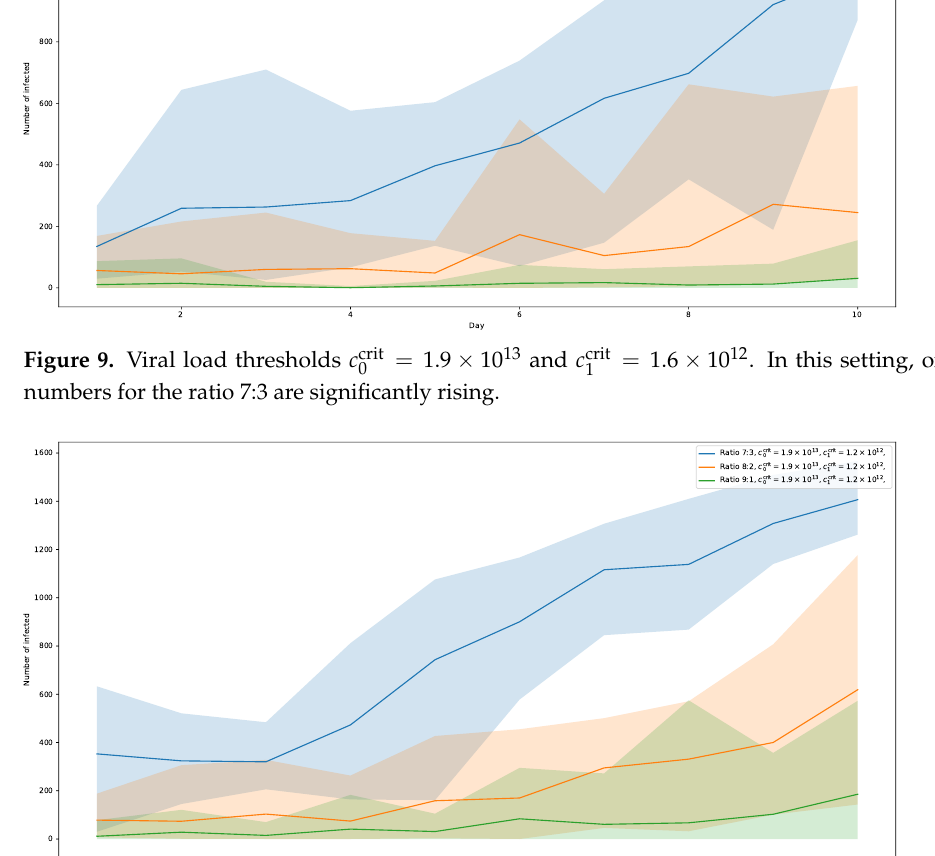
Figure 10. Viral load thresholds c crit significantly rising for ratio 7:3, while for ratio 8:2 also rising, but much slower.